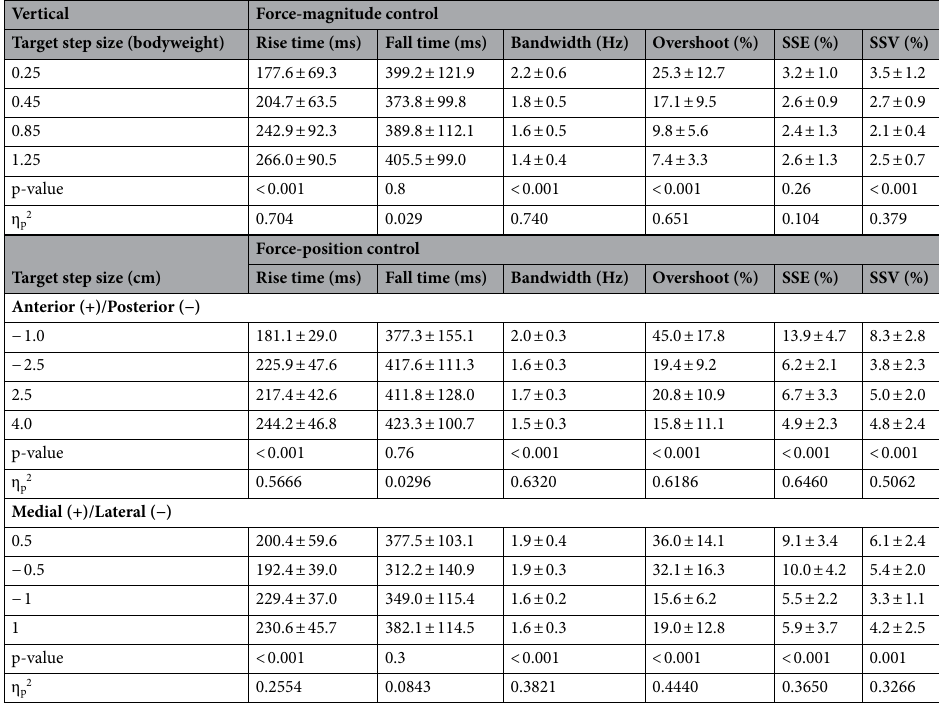
Table 1. Average control characteristics for force-magnitude and force-position control. Significance values from repeated measures analysis of variance and effect sizes (η p 2 ) are presented. SEE steady-state error, SSV steady-state